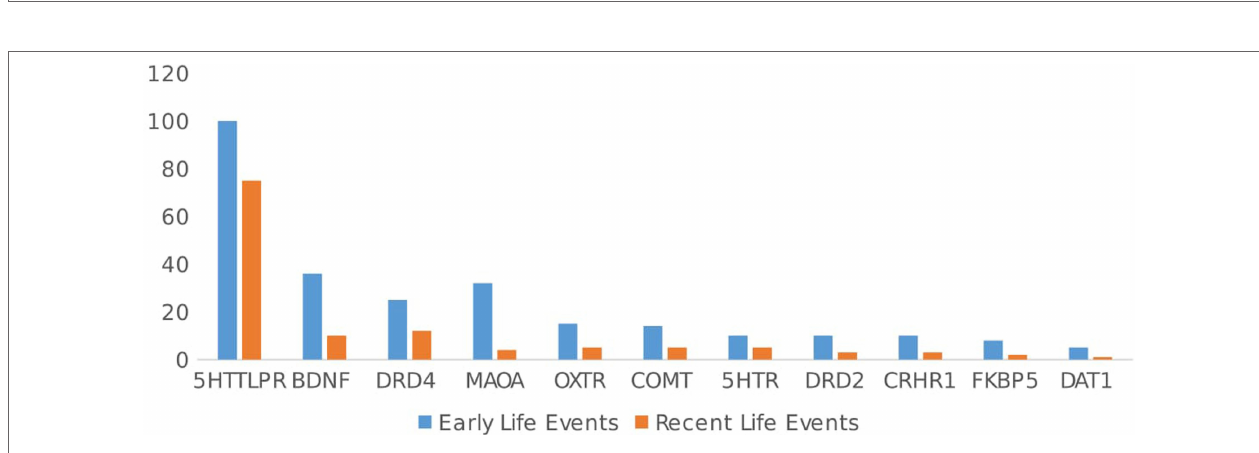
FiGURe 2 | Outcome studied by gene.